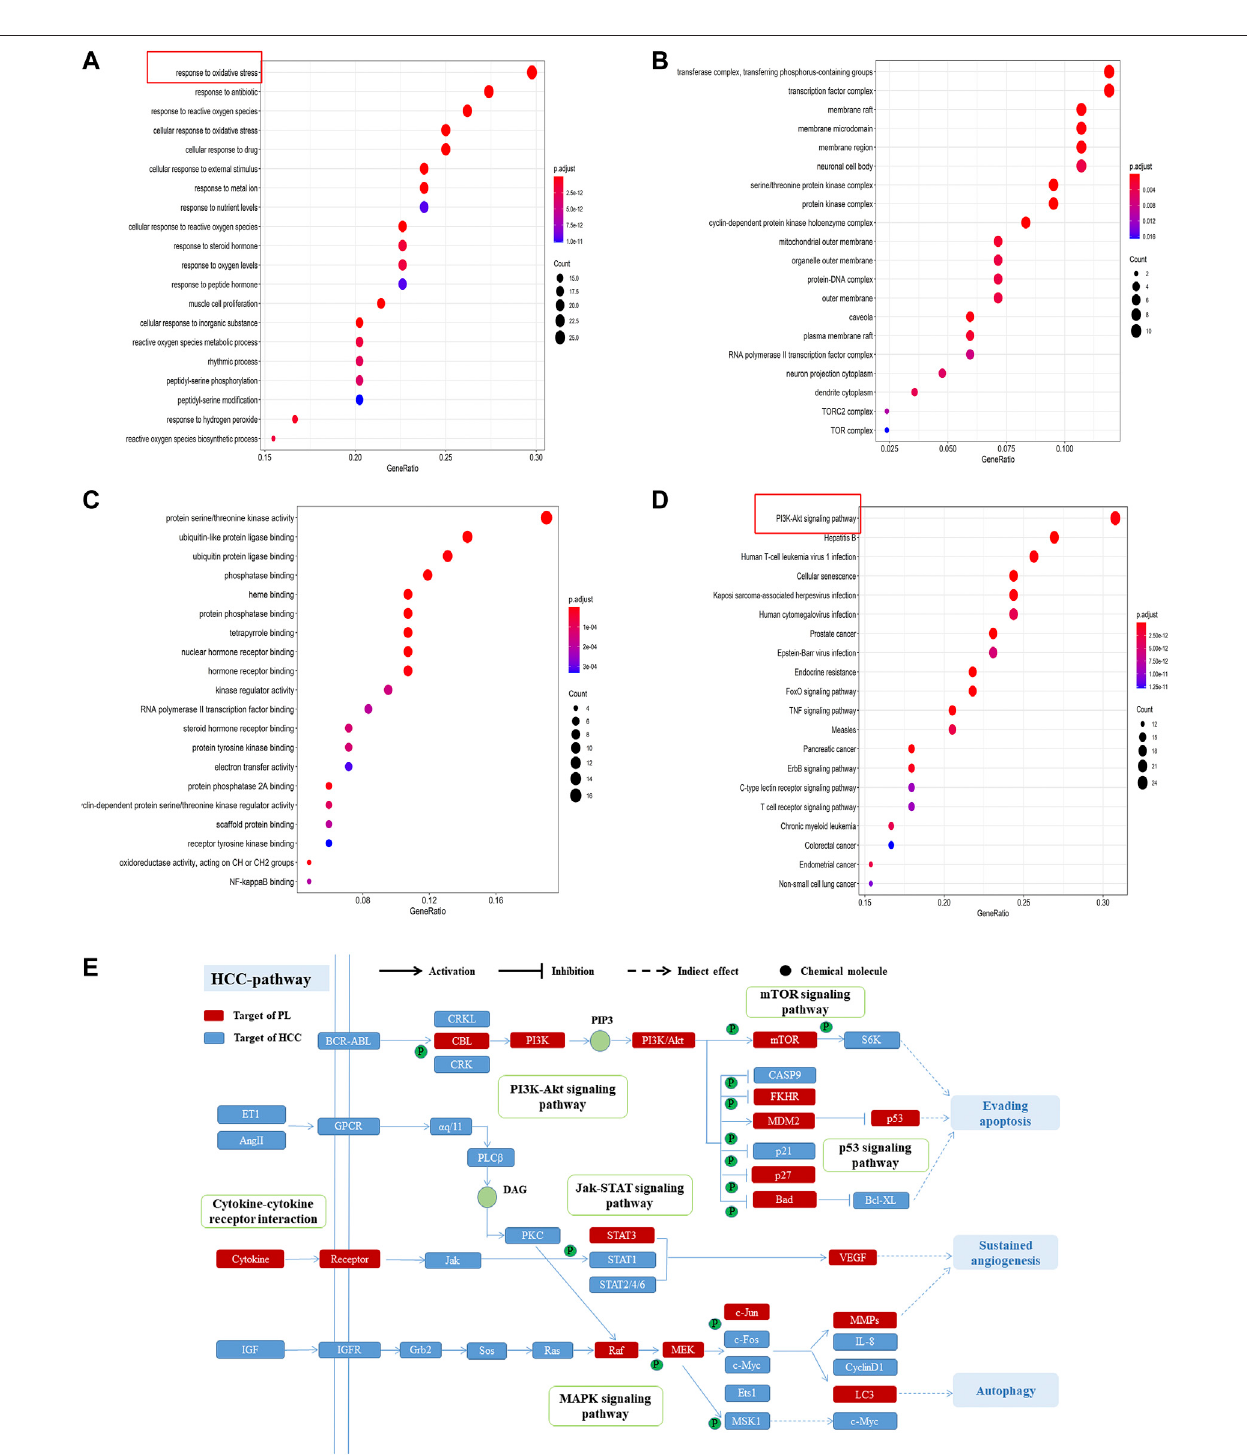
FIGURE 3 | (A) GO enrichment analysis of biological processes of common targets of PL and HCC. The Y-axis represents signi fi cant GO biological processes, and the X-axisrepresentsthecountsofenrichedtargets.Thegradientofcolorrepresentsthedifferentadjusted p values. (B) GOenrichmentanalysisofcellcomponentsofcommontargets ofPLandHCC.TheY-axisrepresentssigni fi cantcellcomponents,andtheX-axisrepresentsthecountsofenrichedtargets.Thegradientofcolorrepresentsthedifferentadjusted p values. (C) GOenrichmentanalysisofthemolecularfunctionsofcommontargetsofPLandHCC.TheY-axisrepresentssigni fi cantGOmolecularfunctions,andtheX-axis represents the counts of enriched targets. The gradient of color represents the different adjusted p values. (D) KEGG analysis for common targets of PL and HCC. The Y-axis representssigni fi cantKEGGpathways,andtheX-axisrepresentstheratioofenrichedtargetsinapathwaytoallcommontargets.Thesizeofthenodesshowsthecountoftargets, and the gradient of color represents the adjusted p value. (E) Distribution of target proteins of PL on the compressed “ HCC pathway. ” Five pathways form the tubular HCC pathway. Arrows show activation activity, T-arrows show inhibition activity, and segments represent indirect activation effects or inhibition effects.